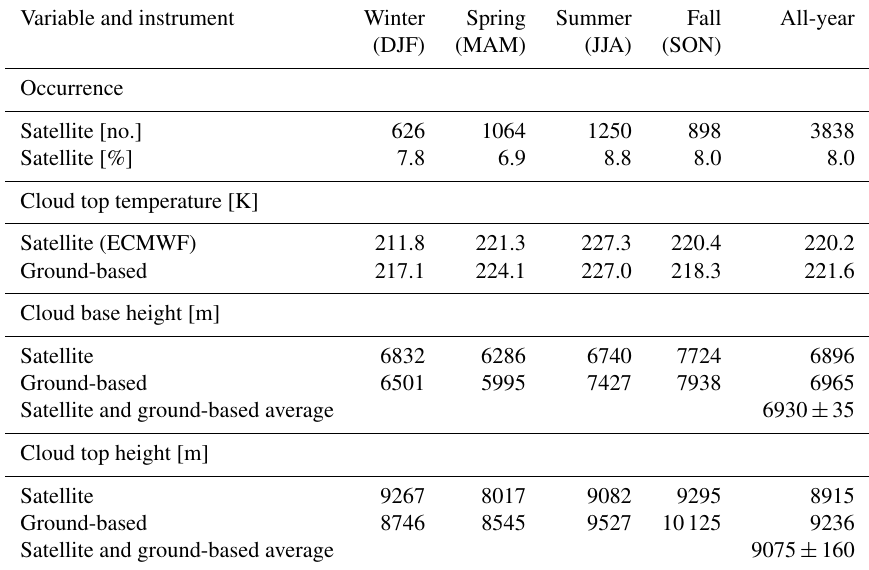
Table 1. The seasonal and multiyear annual (“All-year”) average of occurrence, temperature, and cloud height for the two datasets from the ground- and satellite-based lidar. The occurrence for the satellite is the total number of detections between 2011 and 2017 during the respective